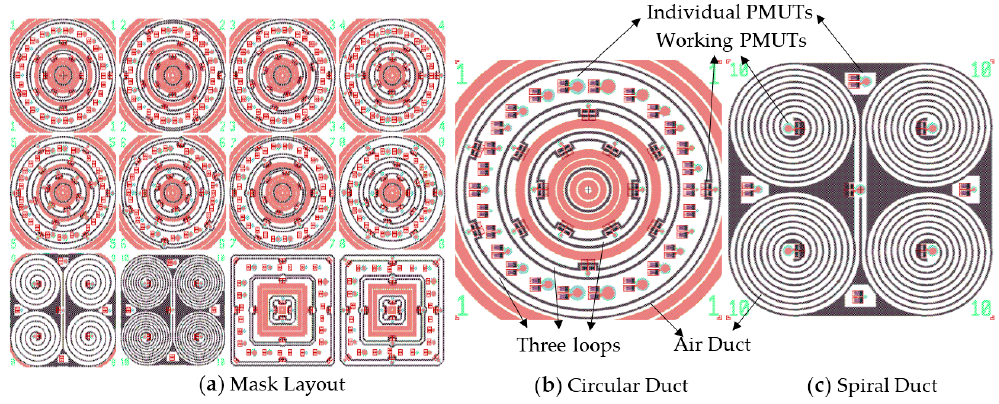
Figure 5. Mask layout with circular, spiral and square shaped air ducts. ( a ) Mask Layout; ( b ) Circular Duct and ( c ) Spiral Duct.